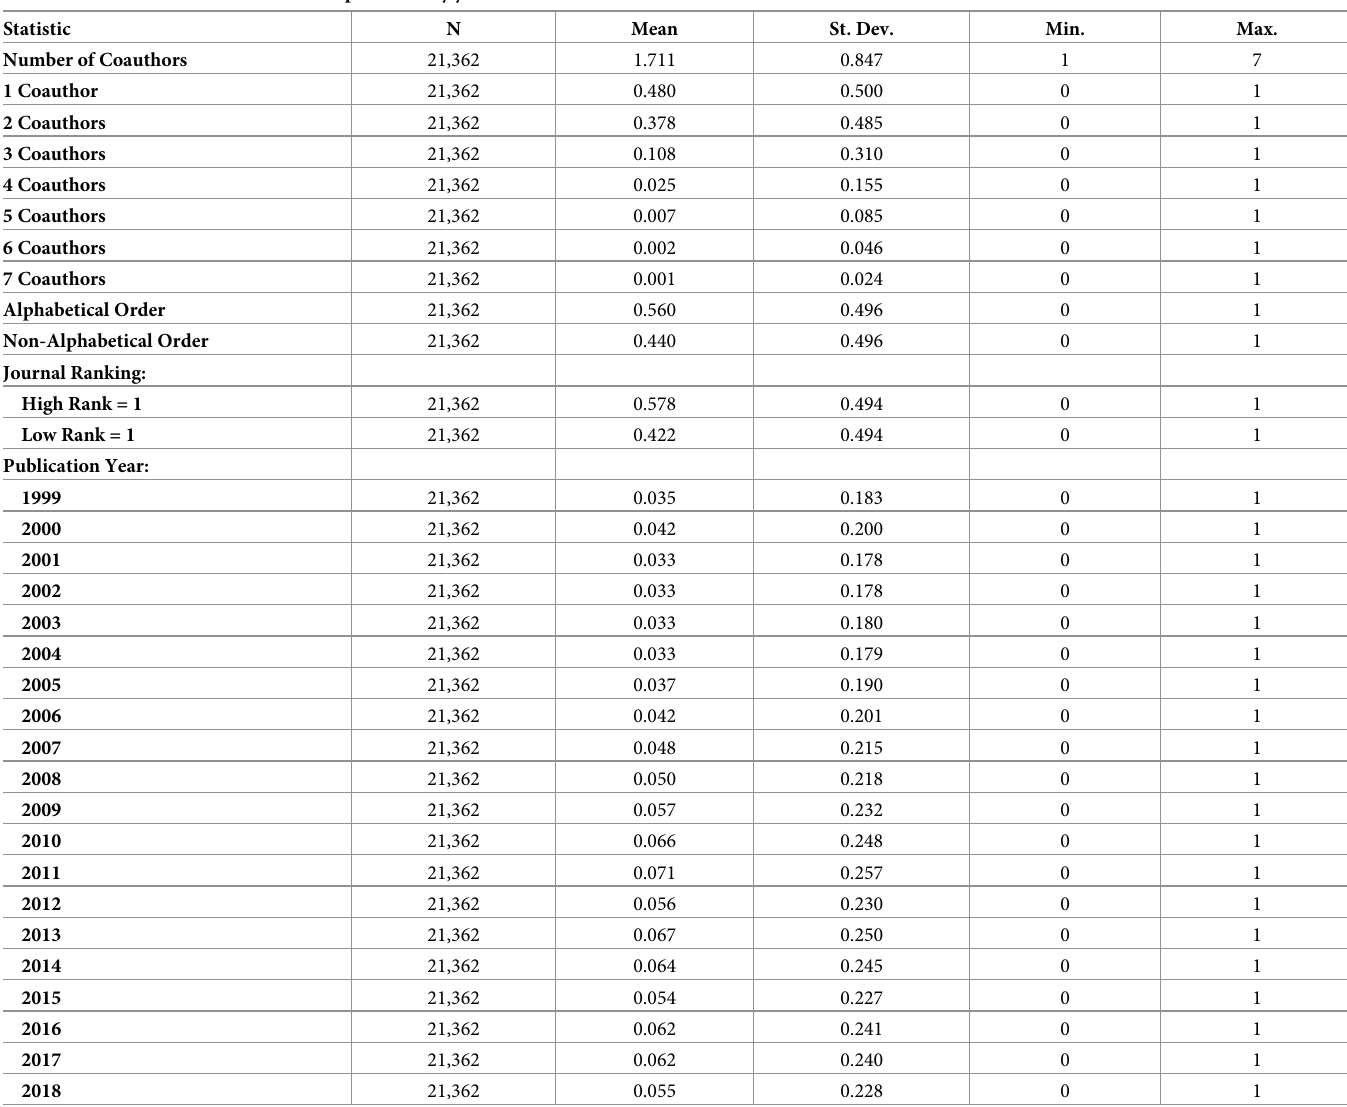
Table 1. Number of coauthors of articles published by